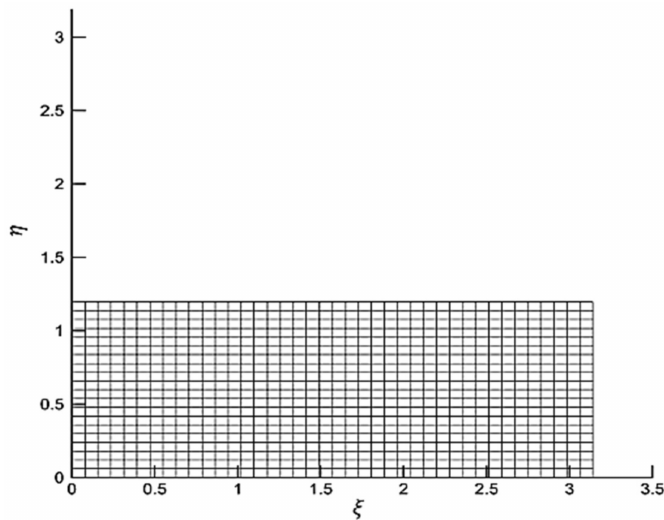
Figure 5. Generated grid in computational space for domain